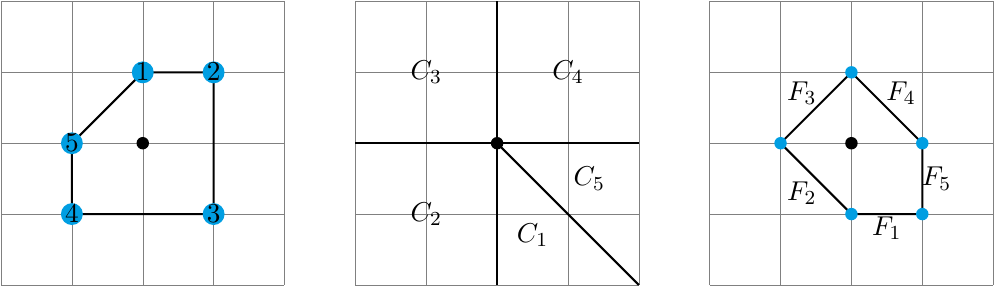
Figure 1 . A pentagon P containing the origin, its normal fan N ( P ) with maximal cones labeled by vertices of P , and the dual polytope P ◦ with facets labeled by vertices of P